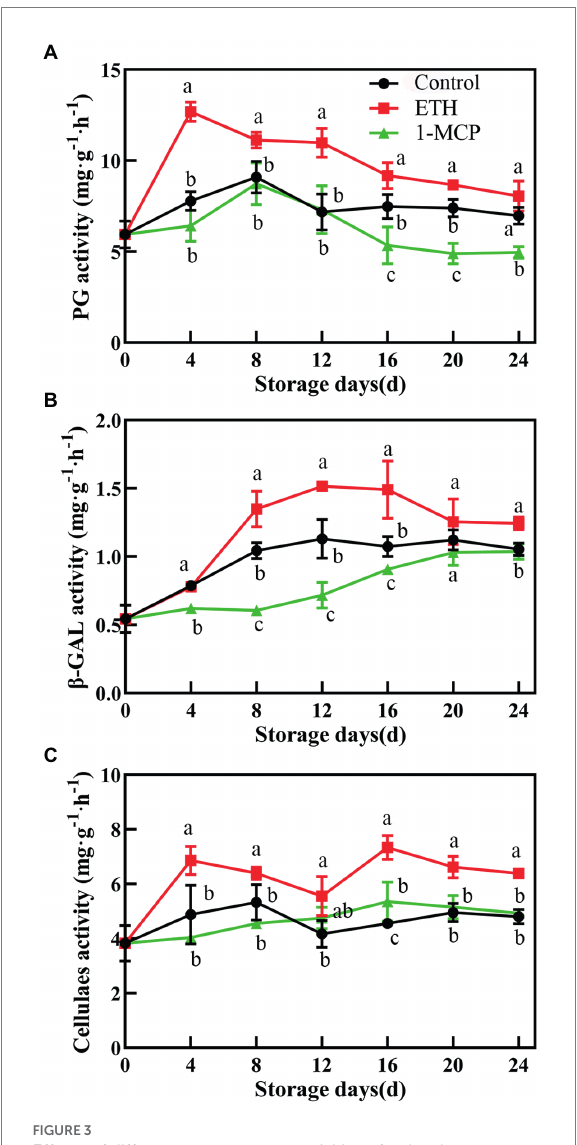
FIGURE 3 Effects of different treatments on activities of polygalacturonase (A) , β -galactosidase (B) , and cellulase (C) in mango fruit during storage at 15 ° C. The data are presented as means ± standard deviations. Means with different letters are significantly different at p <